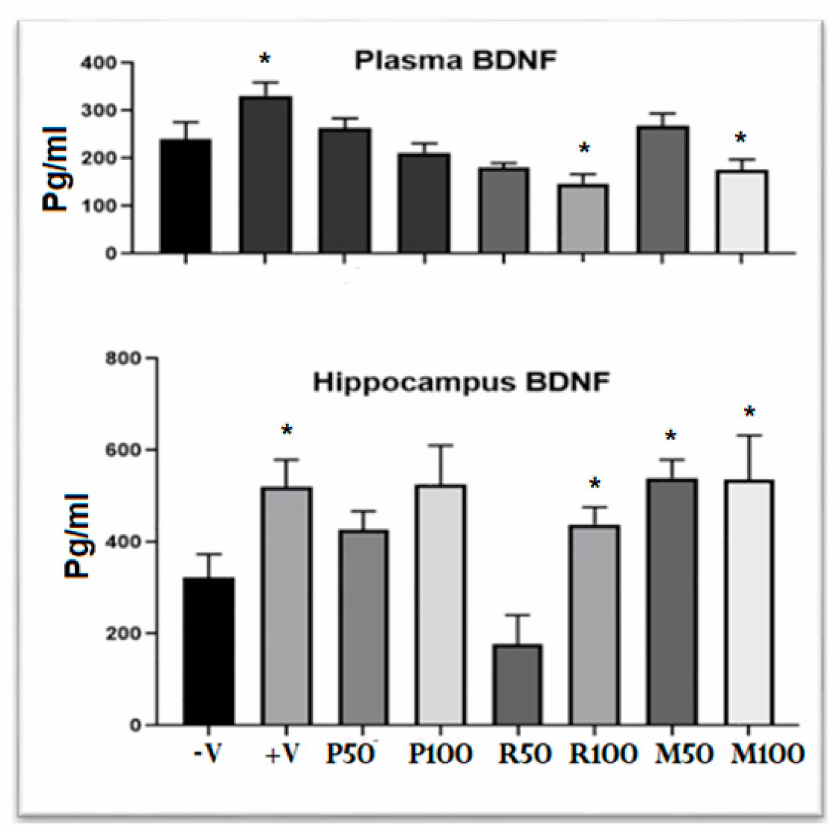
Figure 6. BDNF levels in the plasma and hippocampus of all investigated animal groups. Data are presented as mean ± standard deviation (SD), n = 6 and the statistical analysis was performed by one-way ANOVA followed by Tukey’s post-hoc test, * p < 0.05. Comparison was performed between the positive group and all treatment groups with the negative group. − V = negative; +V = positive; P = peppermint oil extract; R = rosemary oil extract; M = both peppermint oil and rosemary oil extracts in which M50 means: 25 + 25 mg of each oil extract, while M100 means 50 + 50 mg of both extracts.